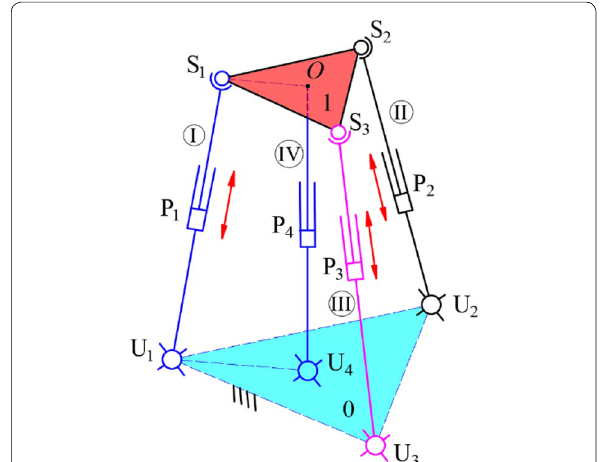
Figure 2 Schematic diagram of 3UPS&UP PM